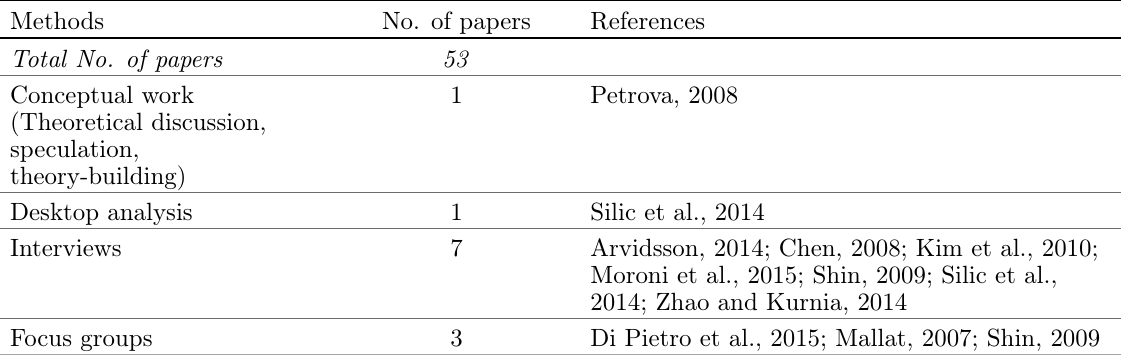
Table B.1 . Research methods used in studies on mobile payments’ customer